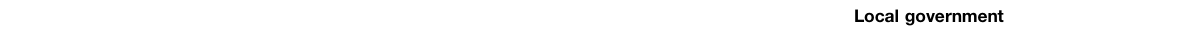
TABLE 1 | One-stage game when the subsidy is given before a spot check.